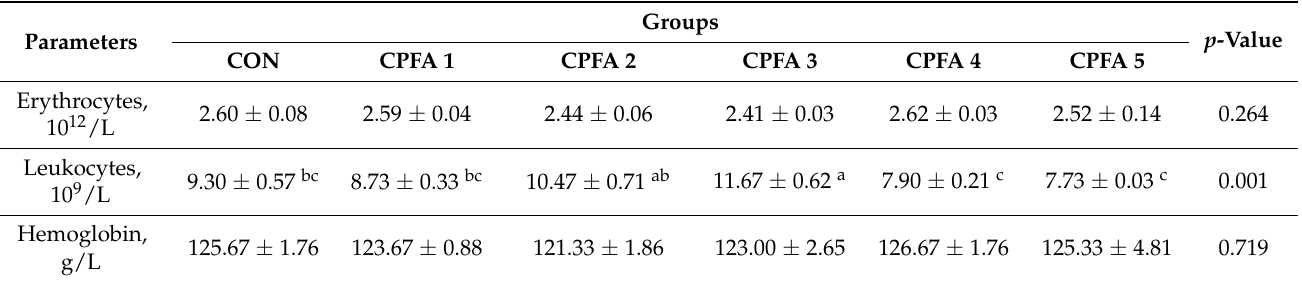
Table 7. Morphological blood parameters of broiler chickens.